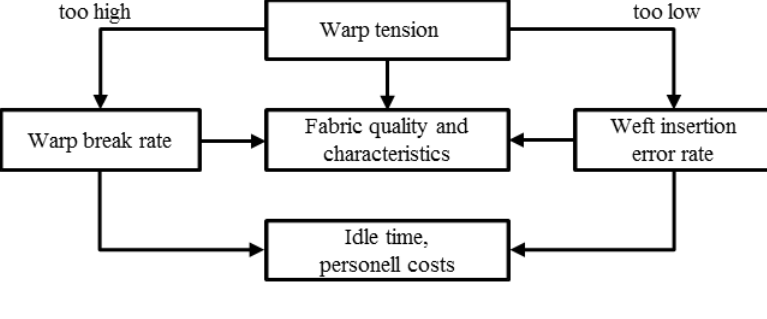
Figure 3. Effects of the warp tension